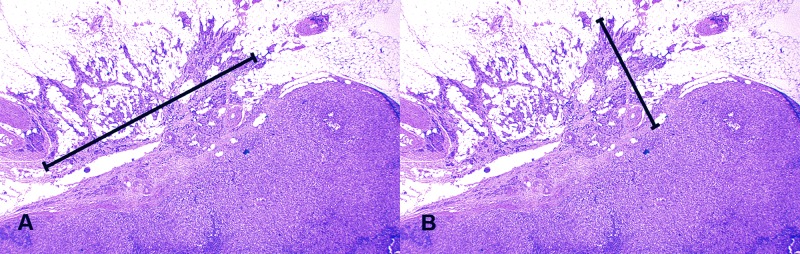
Photographs of metastatic tumor tissue in axillary lymph nodes demonstrating the diameters of extra-nodal extension.A, circumferential diameter; B, perpendicular diameter (x 200 magnification).